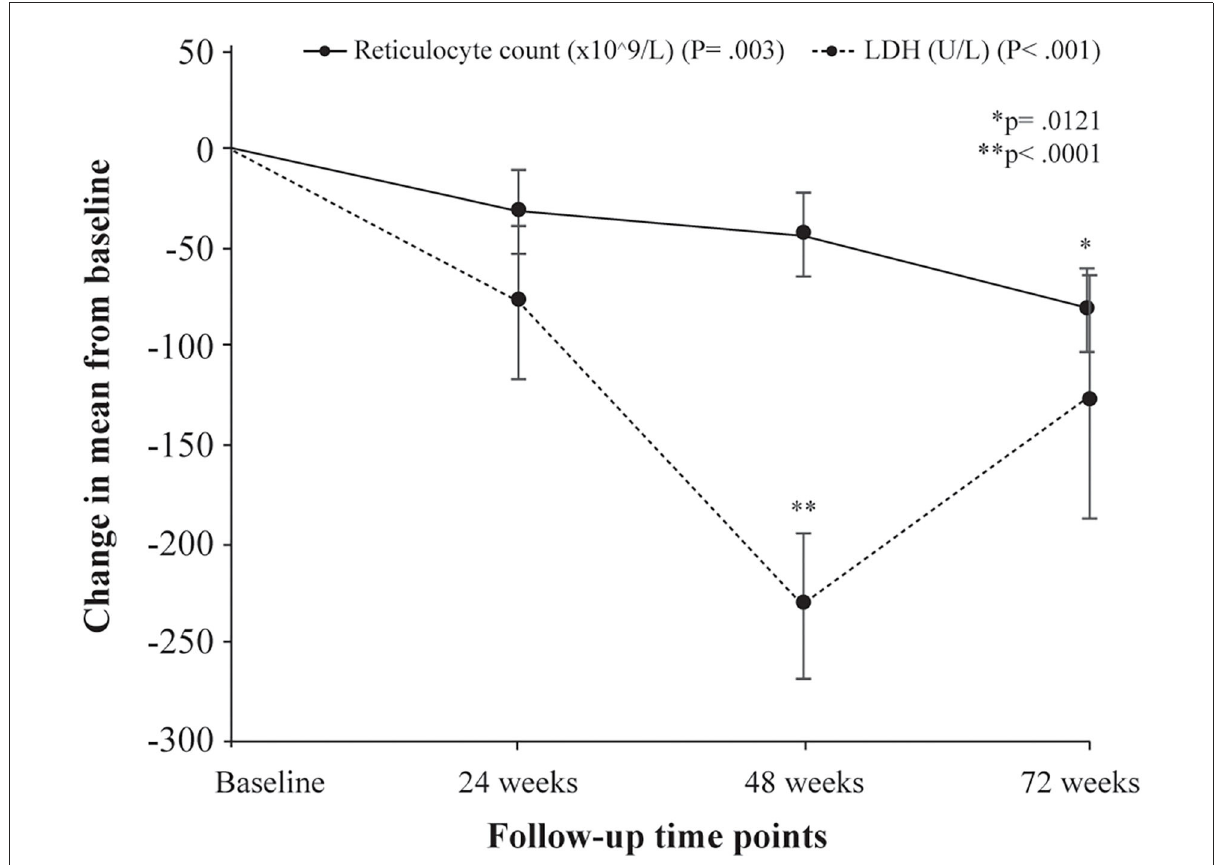
FIGURE2 Change in mean levels of hemolysis markers (reticulocyte counts and LDH levels) from baseline to follow-up time points. P denotes probability values for repeated measures ANOVA; p denotes probability value of pairwise comparison of mean difference (Bonferroni correction) in reticulocyte counts at 72 weeks from baseline ( * ) and LDH levels at 48 weeks from baseline ( **